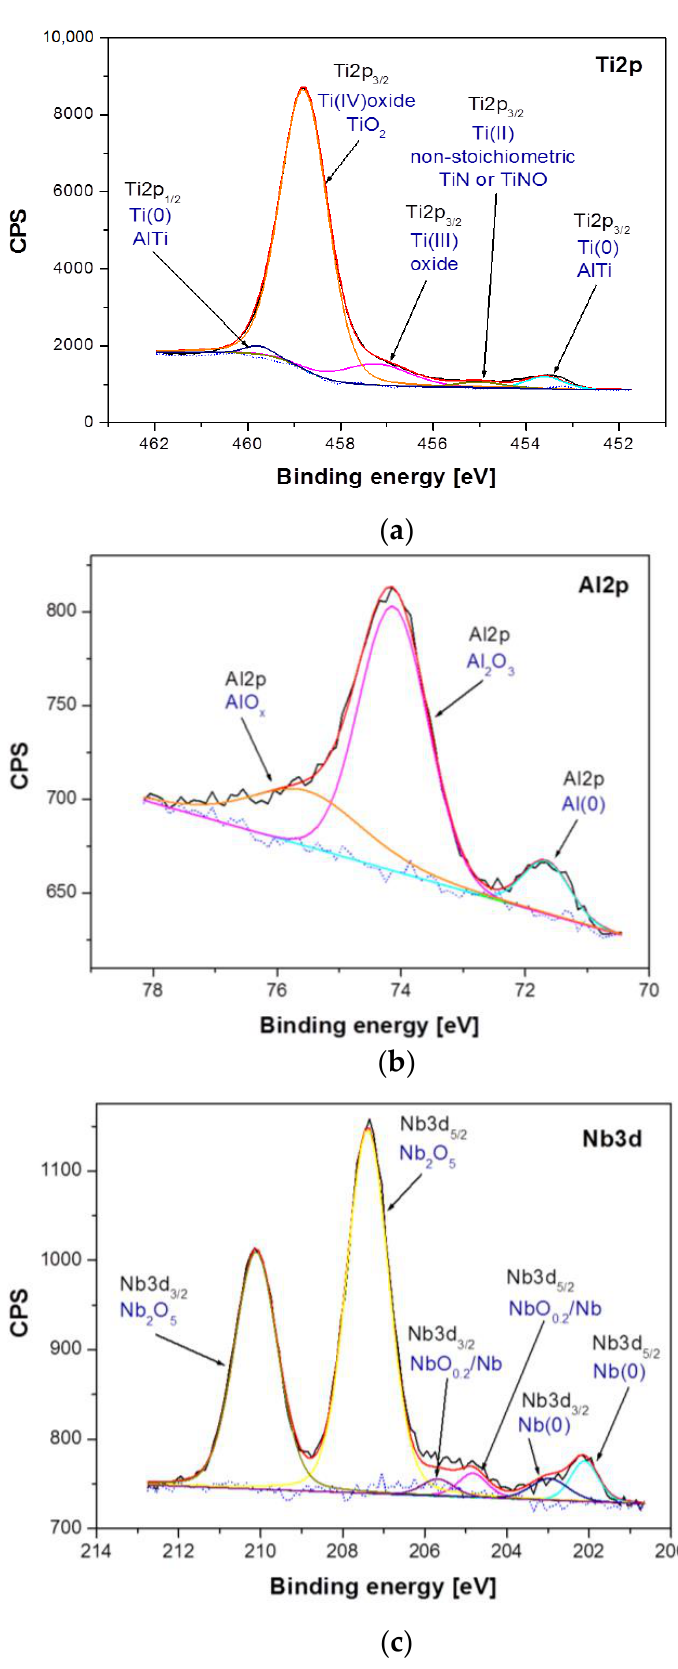
Figure 5. High-resolution XPS spectra for the photoemission line: ( a ) Ti2p; ( b ), Al2p and ( c ) Nb3d, obtained for the Ti – 6Al – 7Nb alloy in the initial state.